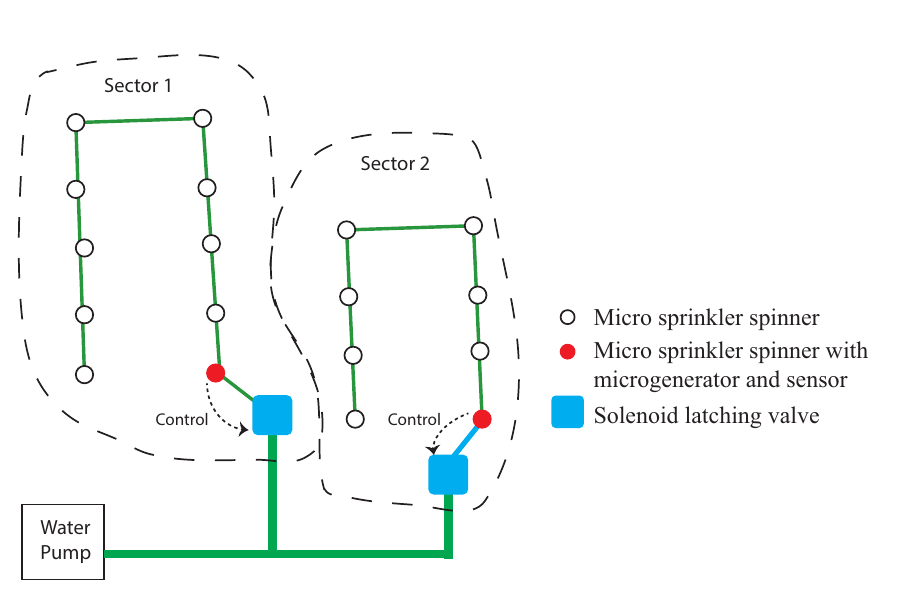
Figure 1. A diagram of the installation of the sensors in a crop